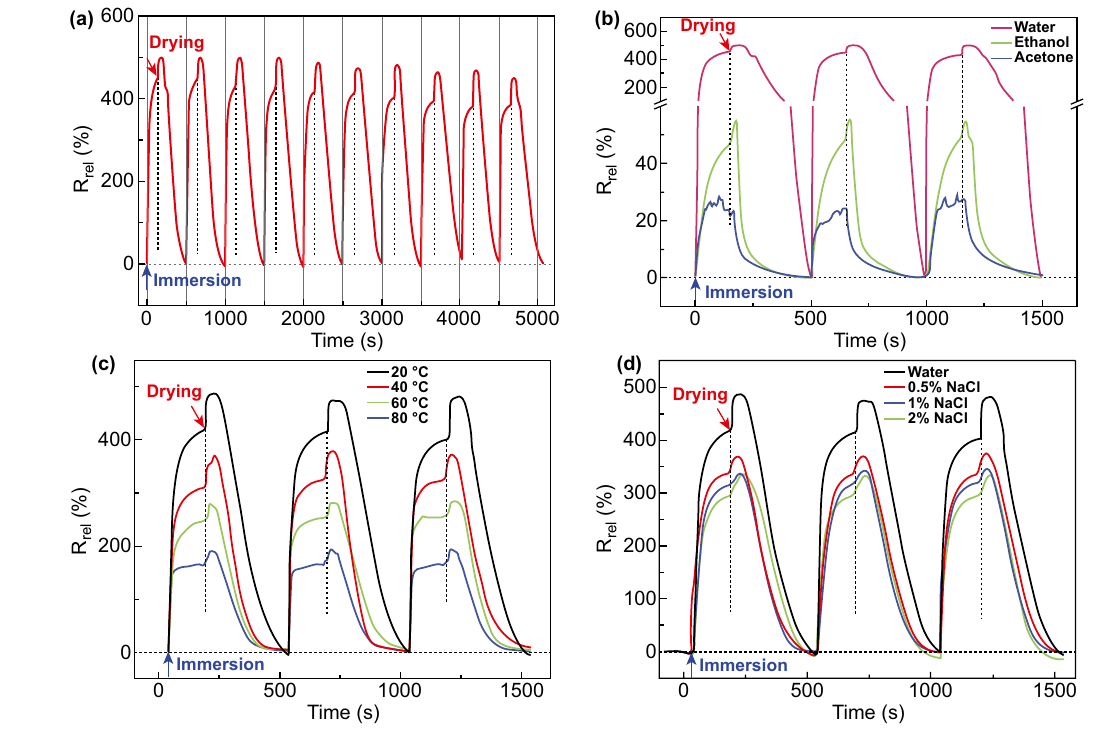
Fig. 22 a – d Hybrid NCs-rGO film relative electrical resistance ( R rel ) changes with time during immersion and drying cycles in water, different solvents, water at different temperatures, and aqueous NaCl solutions (20 °C) at different salt concentrations. Reproduced with permission